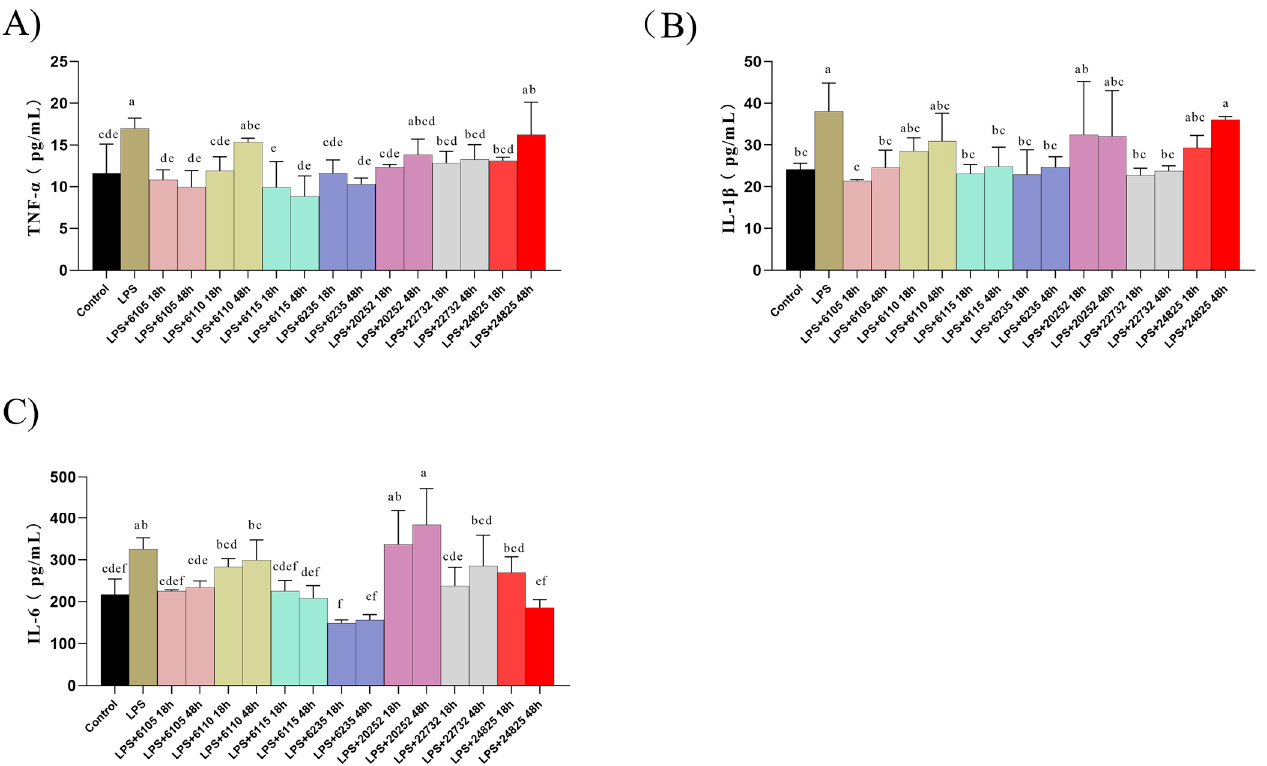
Figure 1. Effect of heat ‐ killed Lacticaseibacillus paracasei (HK ‐ LP) (1 μ g/mL) at different cultivation times (18 h or 48 h) on TNF ‐α ( A ), IL ‐ 1 β ( B ), and IL ‐ 6 ( C ) in lipopolysaccharide (LPS) (100 μ g/mL) ‐ treated Caco ‐ 2 cell monolayers after 24 h. HK ‐ LP 6105, 6110, 6115, 6235, 20252, 22732, and 24825 were incubated for 18 h and 48 h, respectively; after that, they were heat ‐ killed for 30 min at 100 °C. Control: untreated control cells; LPS: LPS ‐ treated cells. Each result is represented as the mean ± standard error of the mean (SEM) from three independent experiments. Different lowercase letters (a, b, c, d, e, f) indicate different levels of significance ( p < 0.05) and the same letters represent no significant difference ( p > 0.05).